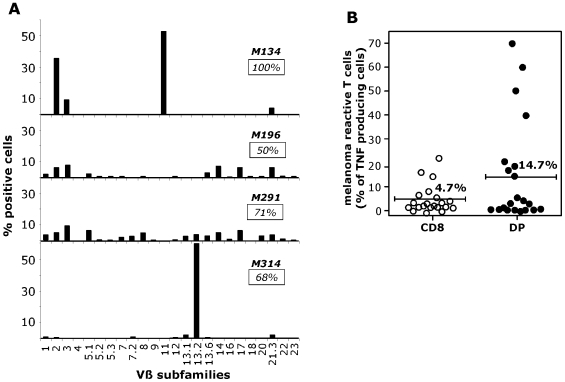
Analysis of polyclonal DP T cells in melanoma: repertoire diversity and autologous-tumor reactivity.A/ Repertoire diversity of DP T cells populations in tumors from four melanoma patients was assessed by labeling with 24 anti-Vβ mAbs. Insets indicate the percentage of the specific population characterized with this panel. B/ Percentage of TNF-producing cells in the SP CD8 and DP sub-populations in response to the autologous melanoma cell line. The autologous tumor cells lines were established from metastatic lymph nodes of 21 melanoma patients and were tested after two at four weeks of culture initiation. 106 ILNL and 2×106 melanoma cells were incubated for 6 h in the presence of Brefeldin A, stained with CD4 and CD8 mAbs, fixed, and stained with anti-TNF Ab in a permeabilization buffer. 105 cells were then analyzed by flow cytometry.